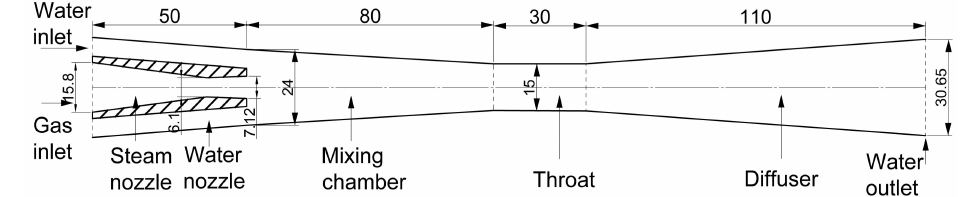
Figure 1. Schematic and principal dimensions of steam–water injector (SI) from Shah’s experiment [15] (all dimensions are in